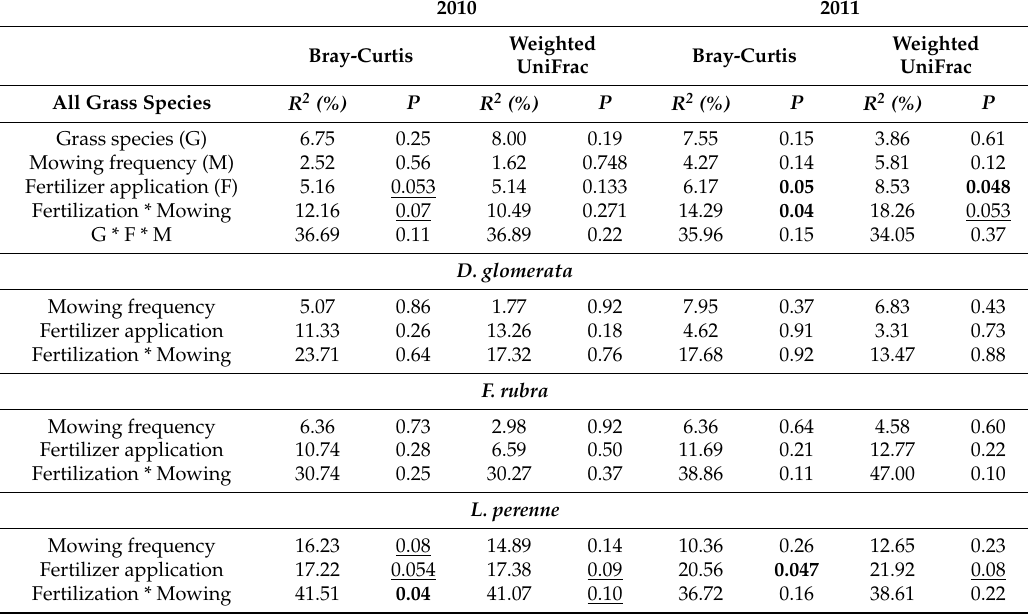
Table 2. Effect of grass species and grassland management regimes on fungal endophyte community composition in 2010 and 2011 based on Bray-Curtis and weighted UniFrac dissimilarities. 2010 Weighted Weighted Bray-Curtis Bray-Curtis UniFrac UniFrac All Grass Species R 2 (%) P R 2 (%) Grass species